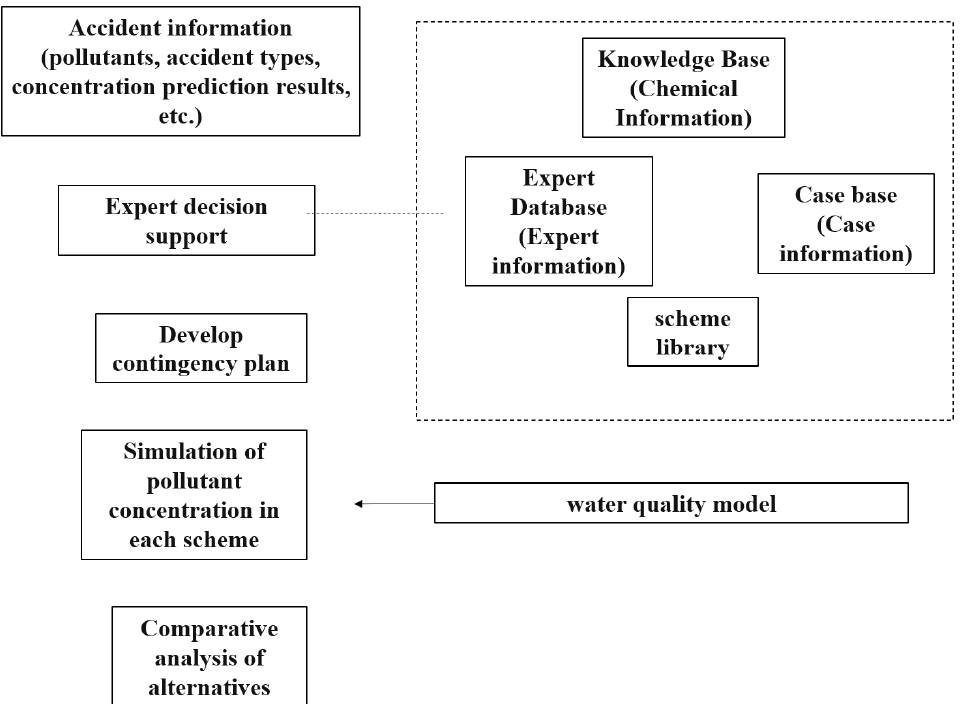
Figure 5. Flowchart of the emergency response system.